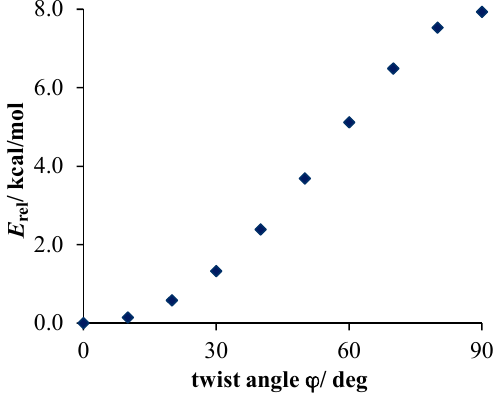
Figure 9. Dependence of the relative energy, E rel , of p -nitroaniline on rotation angle of NO 2 group, φ .